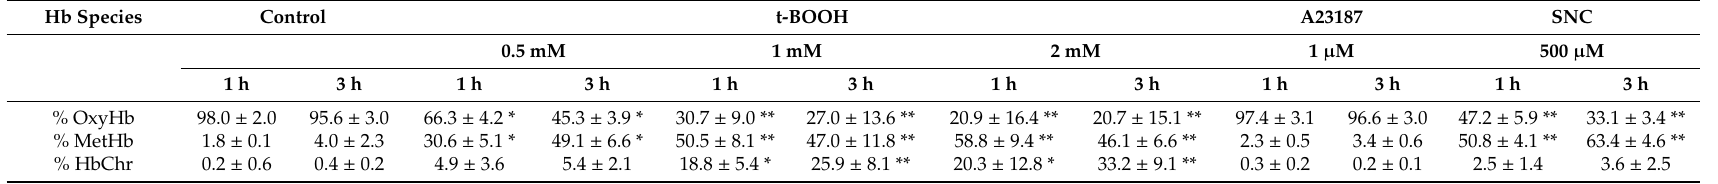
Table 1. The percentage of Hb species formation in response to indicated compounds calculated according to Kanias et al.